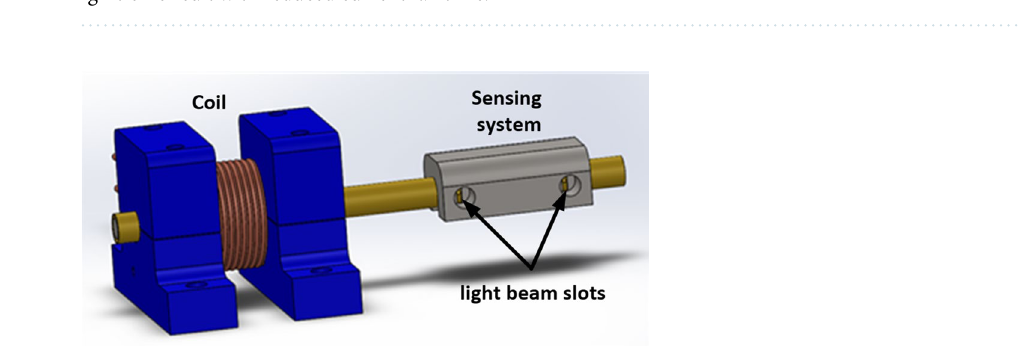
Figure 4. Analytical and experimental results of the capacitor voltage and coil current for the energy recycling ignition circuit with reduced current fall time.